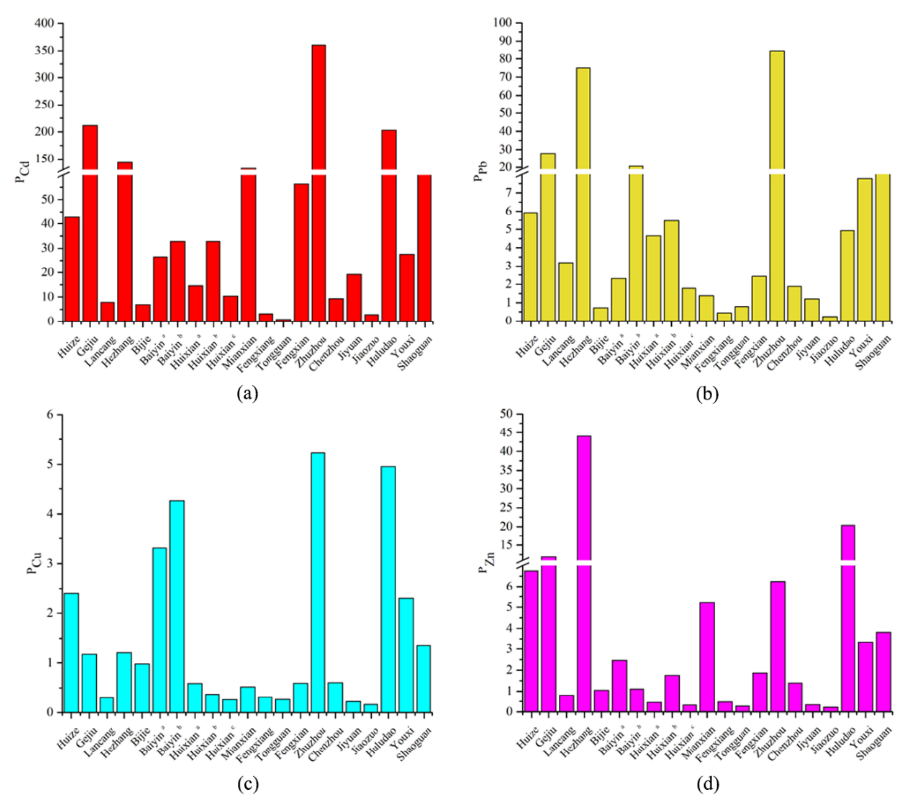
Figure 4. Single pollution index of heavy metal in soil. ( a ) pollution index of Cd; ( b ) pollution index of Pb; ( c ) pollution index of Cu; ( d ) pollution index of Zn.